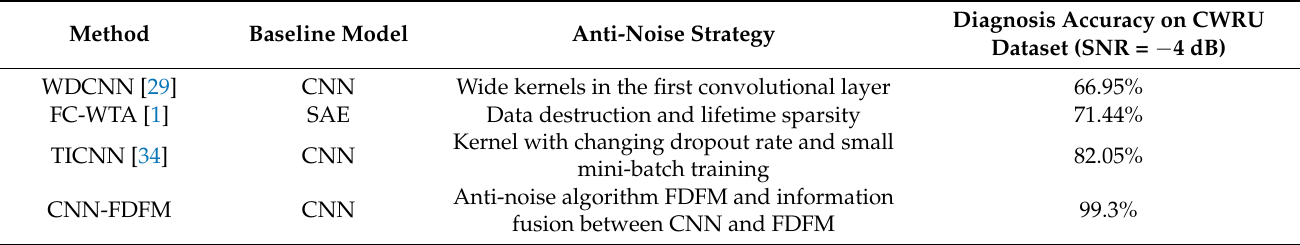
Table 8. Comparison with other anti-noise methods based on CWRU dataset.